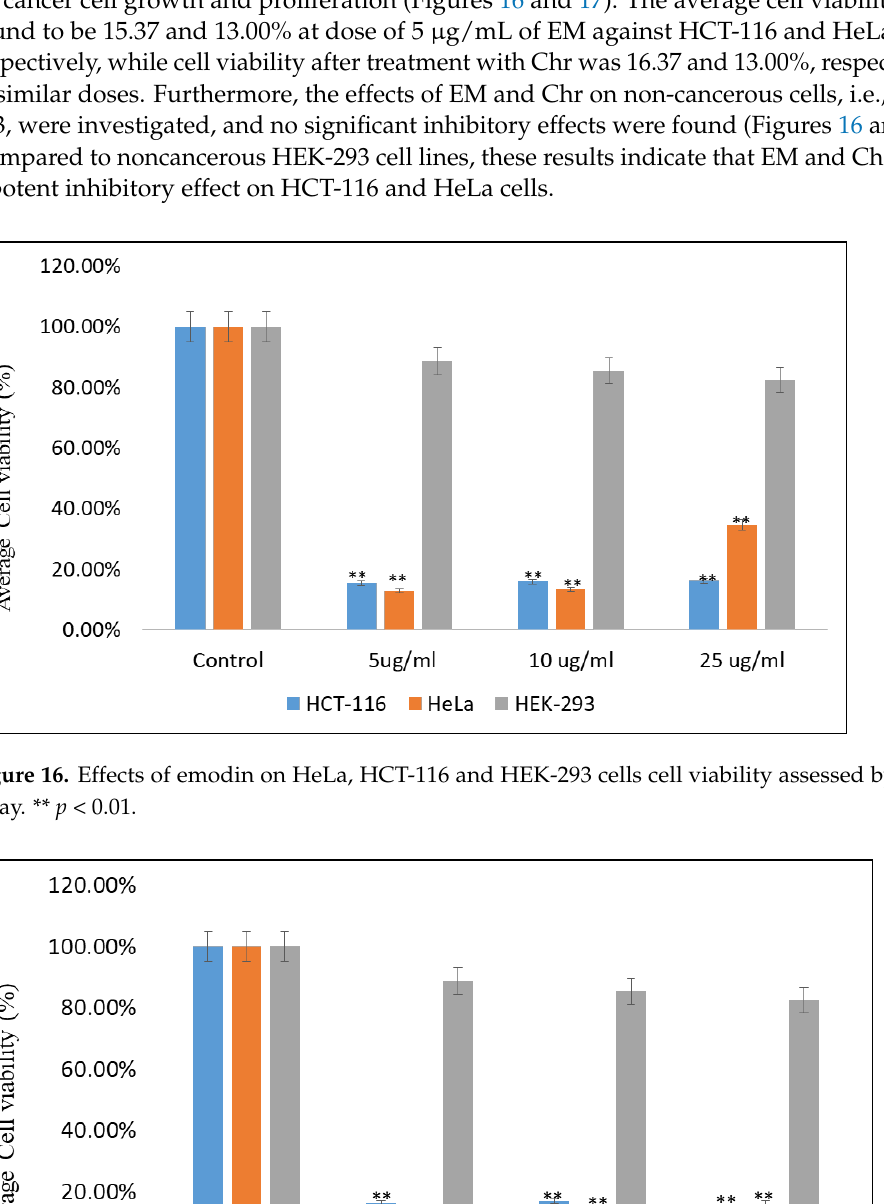
Figure 18. Cancer cells morphology by DAPI staining. ( A ) Control; ( B ) and ( C ) treated with 40 µg/mL of chrysophanol and emodin, respectively. 3. Discussion Anthraquinone, also known as 9,10-dioxoanthracene, is a class of natural and syn- thetic chemicals with a wide range of biological functions. In recent years, there has been a great deal of interest in the synthesis of anthraquinone derivatives, as well as in the modification of their structures and the evaluation of their bioactivity. EM and Chr are the most important anthraquinone analogues [19]. In drug development, anthraquinones have become an important family of chemicals due to their wide range of biological char- acteristics. Using the computational process known as molecular docking, it is feasible to anticipate how a ligand will bond to a protein with a given three-dimensional structure [20]. As a result, it is extremely desirable to investigate the potential of these anthraqui- none libraries to discover hit or lead-like compounds for future research. We found less literature on anthraquinone analogue binding mechanisms and interaction energy with caspase-3, apoptosis regulator Bcl-2, TNIK, and CDK2, important cancer-related protein